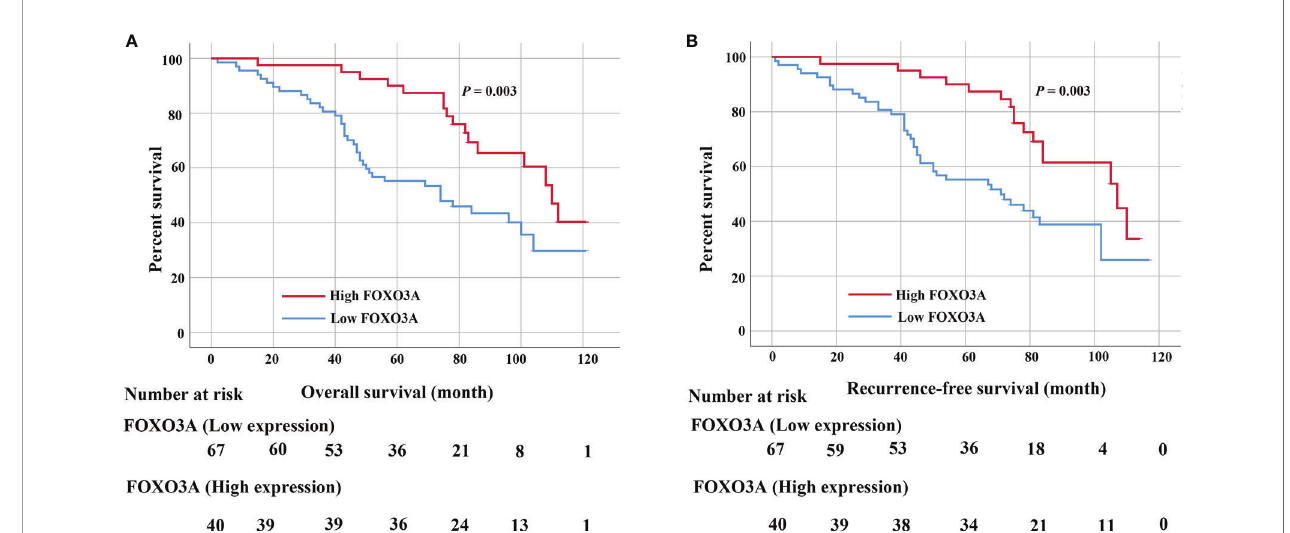
FIGURE 2 | (A) Kaplan – Meier curves for the 5-year OS rate of patients with UTUC and OS based on FOXO3a in UTUC patients. (B) Kaplan – Meier curves for the 5- year RFS rate of patients with UTUC and RFS based on FOXO3a in UTUC patients. Error bar = SEM.